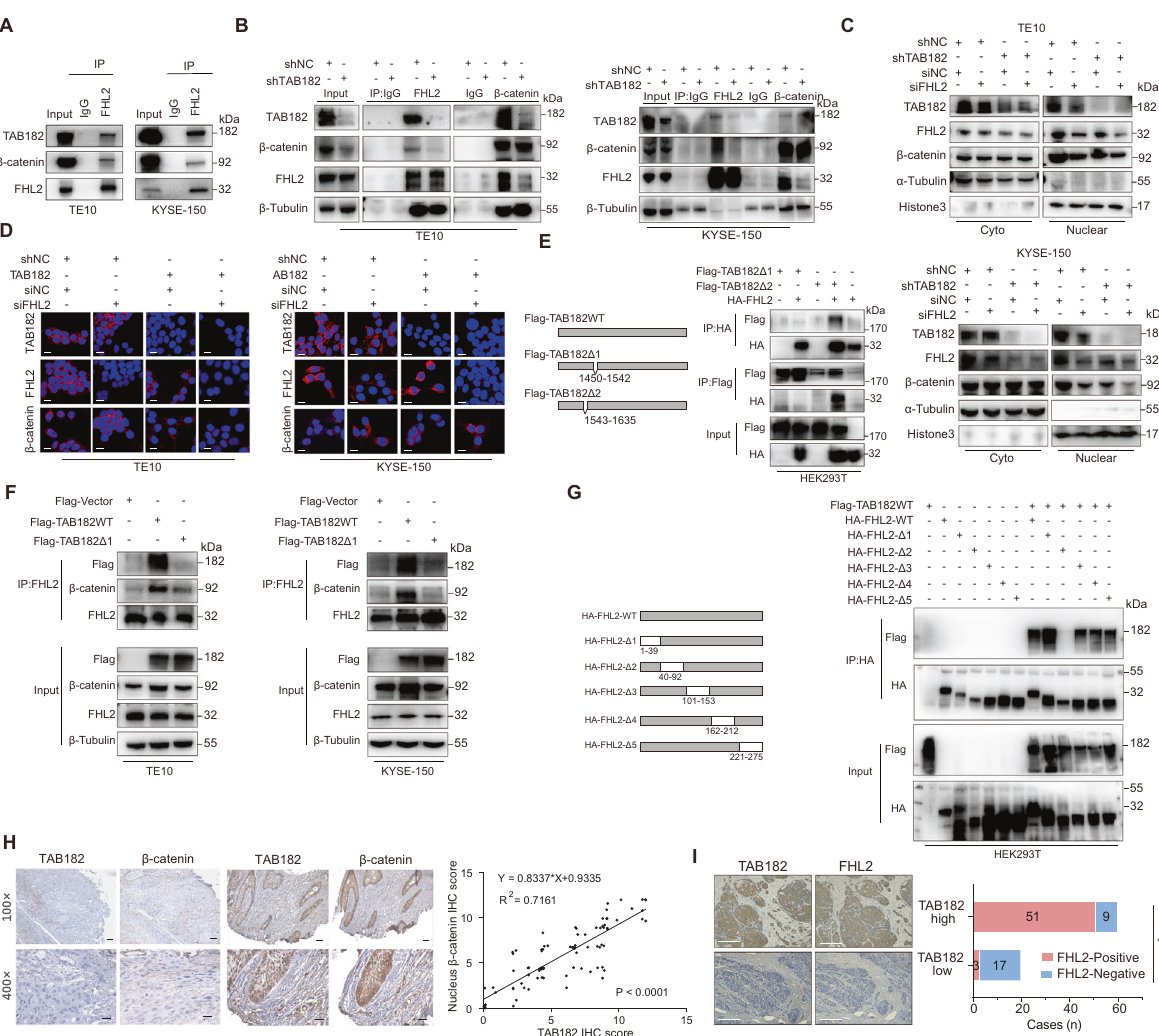
Fig. 4 TAB182 regulates nucleus translocation of β -catenin via interacting with FHL2. A the interaction between TAB182, FHL2 and β -catenin were determined by immunoprecipitation followed by immunoblotting analysis. B the interaction between FHL2 and β -catenin in TAB182 silenced cells was detected by immunoprecipitation. C the distribution of β -catenin in TE-10 and KYSE-150 cells was evaluated by fractionation followed by western blot analysis. D the distribution of β -catenin in TE-10 and KYSE-150 cells was evaluated by immuno fl uorescence staining. E determining the interaction domain of TAB182 with FHL2 in HEK293T cells by immunoprecipitation assay. HEK293 cells were transfected with Flag-TAB182 or HA-FHL2 plasmid for 48 h, followed by co-IP and western blot. F the interaction between FHL2 and β -catenin was determined in the TAB182- Δ 1cells and TAB182-WT cells by immunoprecipitation assay in TE-10 and KYSE-150 cells. G determining the interaction domain of FHL2 with TAB182. Co-immunoprecipitation assay showed the ability of fi ve mutants of FHL2 binds to TAB182 by immunoprecipitation assay. HEK293 cells were transfected with Flag-TAB182 or HA-FHL2 plasmid for 48 h, followed by co-IP and western nlot. H the correlation between TAB182 and nucleus β -catenin expression in ESCC samples was analyzed by immunohistochemistry and Pearson correlation analysis (r = 0.7161, P < 0.0001). I representative immunohistochemistry-stained images of ESCC tissues using the anti- TAB182 and anti-FHL2 antibodies. **, p <